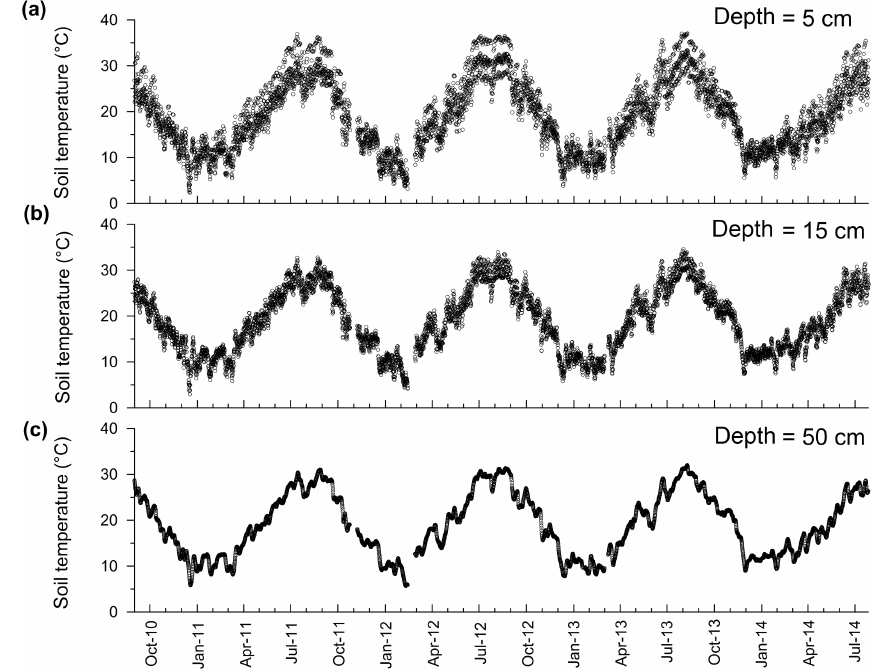
Figure 7. Evolution of temperature, T , recorded by the physical model of lysimeter: (a) soil temperature at depth of 5cm; (b) soil temperature at depth of 15cm; (c) soil temperature at depth of 50cm.